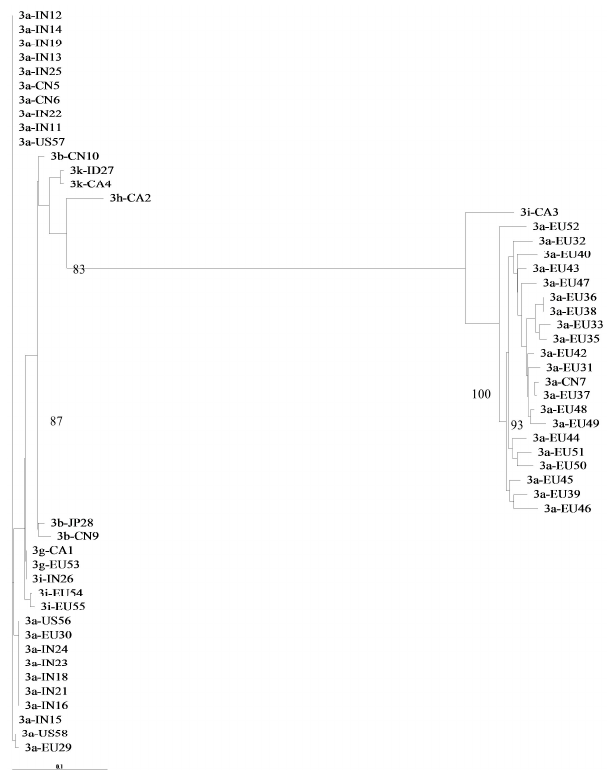
Figure 3. Phylogenetic tree of the 5 ′ UTR region of 53 complete genomes retrieved from Los Alamos database. The maximum-likelihood phylogenetic rooted tree shows the relationships between different GT-3 subtypes of 53 isolates that had 5 ′ UTR sequences available for analysis. Evolutionary distances are indicated next to the branches. Two isolates (CA2, CA3) clustered with GT-3A, but were identified as GT-3I and GT-3H subtypes, respectively, in a NS3, NS5A and NS5B phylogenetic analysis .